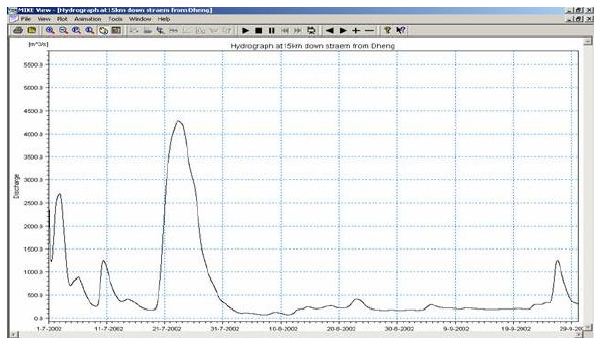
Fig. 4.1. Longitudinal Water profile with maximum level at Runnisaidpur and Mathrapur Joki on 25.7.02 at 12.00